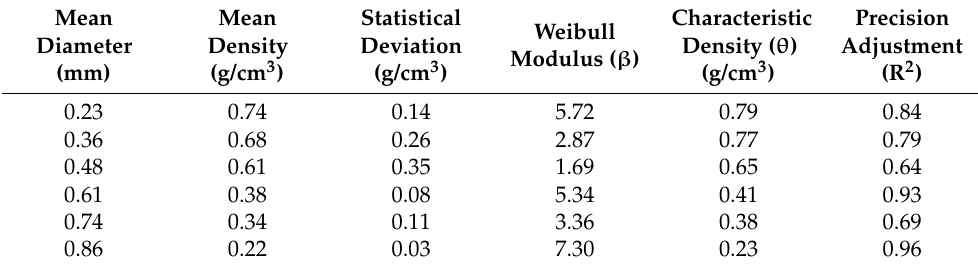
Table 2. Characteristic mean diameter for each interval of sedge fiber